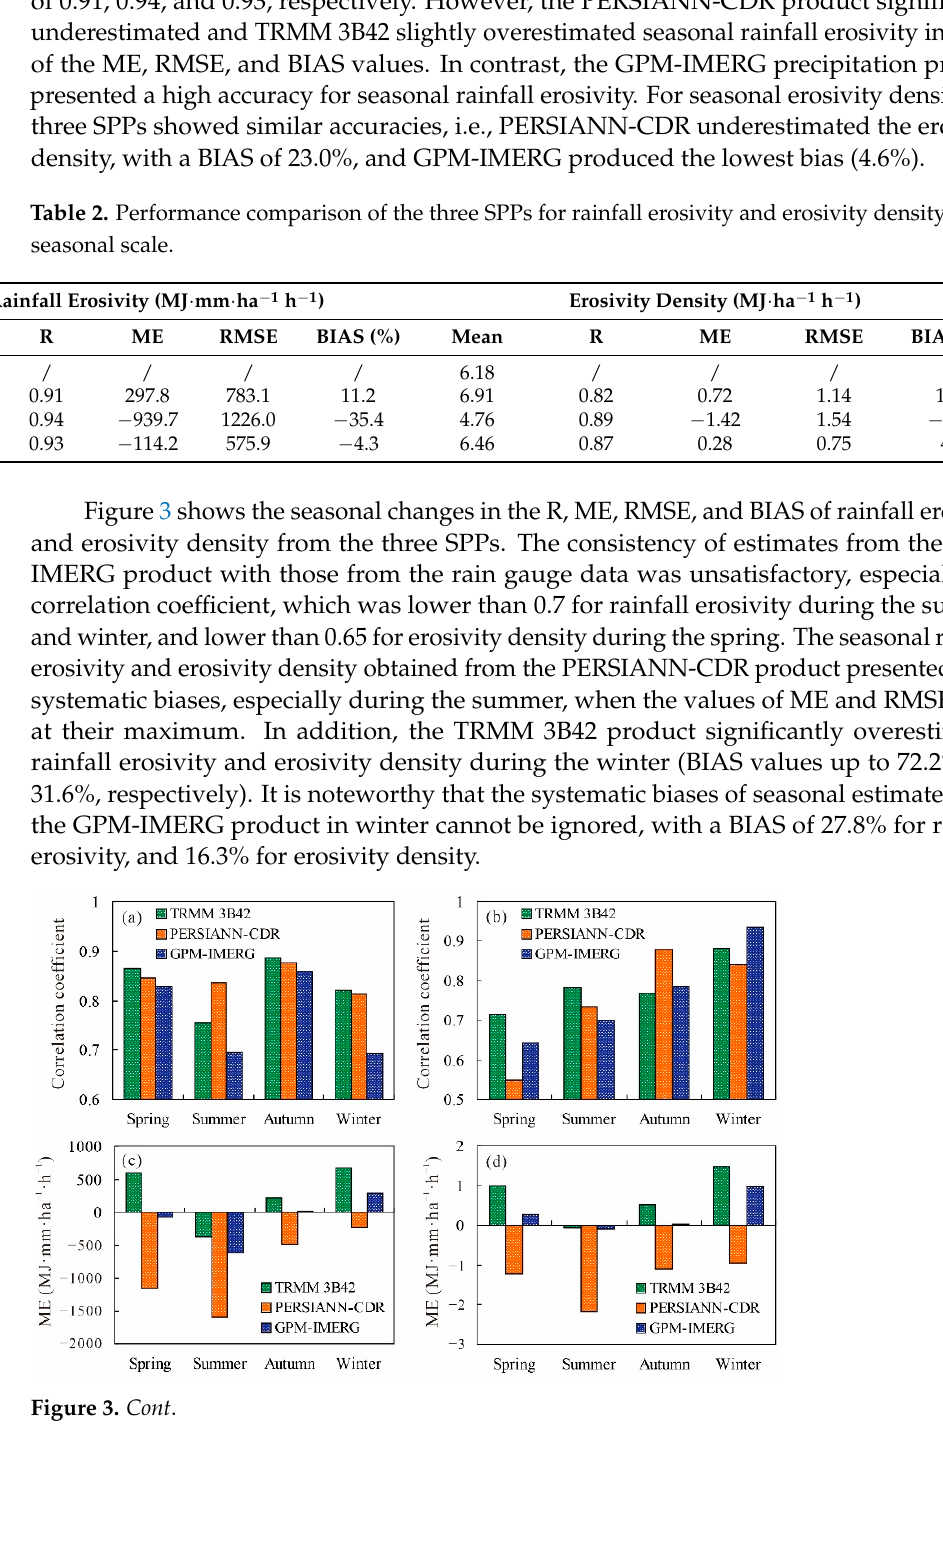
Figure 3. Seasonal variation of R, ME, RMSE, and BIAS (( a , c , e , g ) for rainfall erosivity; ( b , d , f , h ) for erosivity density). 3.2. Performance at Different Rainfall Erosivity Intensities Figure 4 shows the frequency of rainfall erosivity in different intensity categories and its contribution to the annual rainfall erosivity on monthly and seasonal scales. It is seen that, on the monthly scale, the small intensity category (<500 MJ·mm·ha − 1 h − 1 ) had the high- est frequency of occurrence (approximately 38.3%). However, its contribution to the total annual rainfall erosivity was low (10.1%). As the intensity category of rainfall erosivity changed from 500–1000 MJ·mm·ha − 1 h − 1 to 2000–2500 MJ·mm·ha − 1 h − 1 , its frequency de- creased from 27.3% to 6.4%, and the contribution rate decreased from 21.7% to 16.3% for the estimates from the rain gauge data. In particular, although the frequency was very low (3.8%) in the heavy rainfall erosivity group (>2500 MJ·mm·ha − 1 h − 1 ), the corresponding contribution rate was still high (13.8%). As for the estimates from TRMM 3B42 and GPM- IMERG, the distributions of rainfall erosivity and their corresponding contribution rates in different intensity groups were almost consistent with that of the gauge-based rainfall erosivity. However, the PERSIANN-CDR product significantly overestimated the fre- quency and contribution rate of light rainfall erosivity, such as in the categories of <500 and 500–1000 MJ·mm·ha − 1 h − 1 , but underestimated them for heavy rainfall erosivity, such as in groups of 2000–2500 and >2500 MJ·mm·ha − 1 h − 1 (Figure 4a). On the seasonal scale, the gauge-based rainfall erosivity showed the highest occur- rence (37.5%) in the <1500 MJ·mm·ha − 1 h − 1 group, but the largest contribution rate (41.2%)